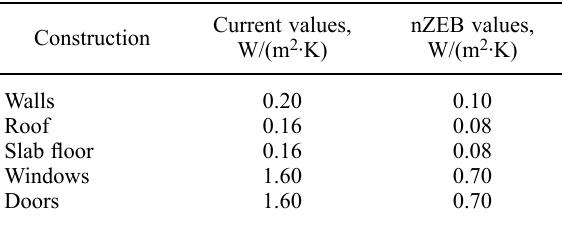
Table 1. Comparison of U values (W/(m 2 ∙ K)) (U – coefficient of thermal conductivity) for residential buildings in Lithuania according to current and 2020 standards (STR